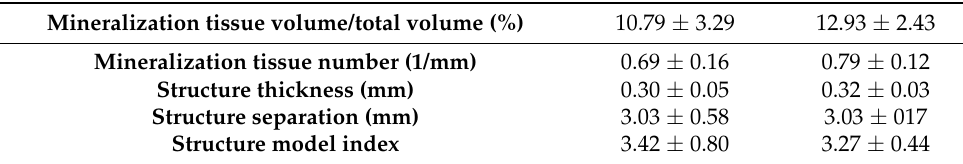
Table 1. Micro-CT evaluation at 40 weeks.